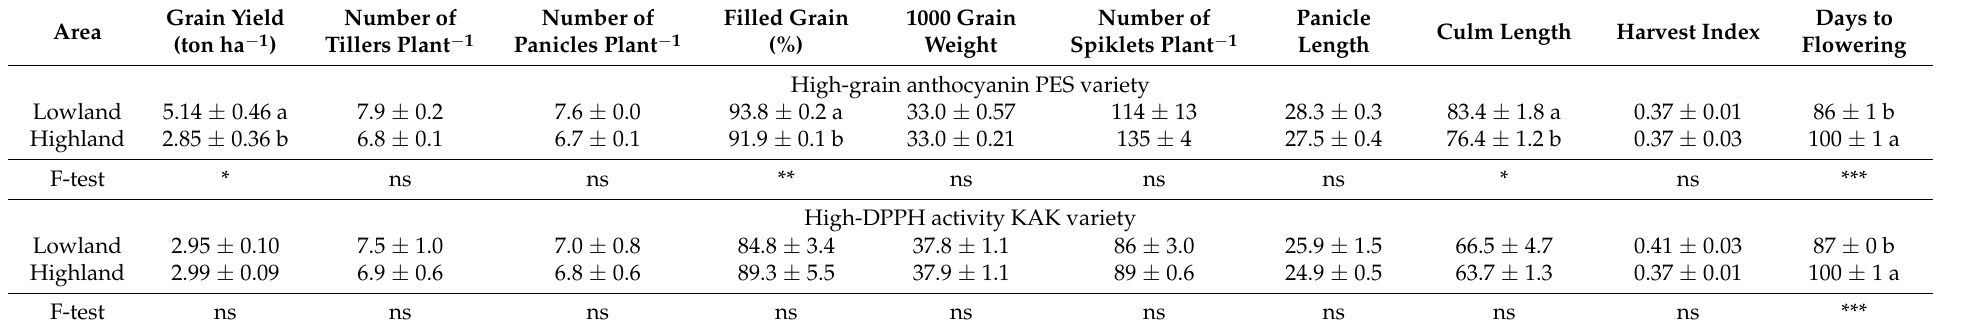
Table 1. Grain yield and agronomic characteristics of two glutinous purple rice varieties (high-anthocyanin PES and high-antioxidant capacity KAK) grown in two